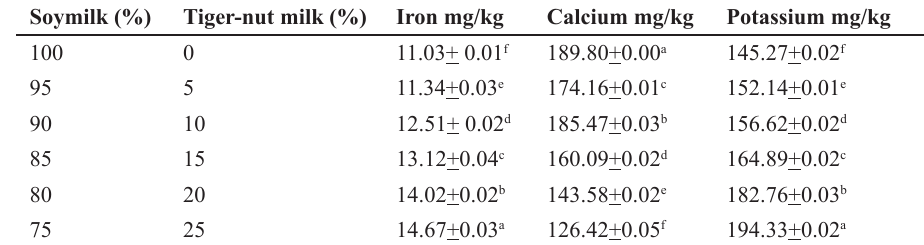
Table 3: Mineral composition of soy/soy-tiger-nut blend. Soymilk (%) Tiger-nut milk (%) Iron mg/kg